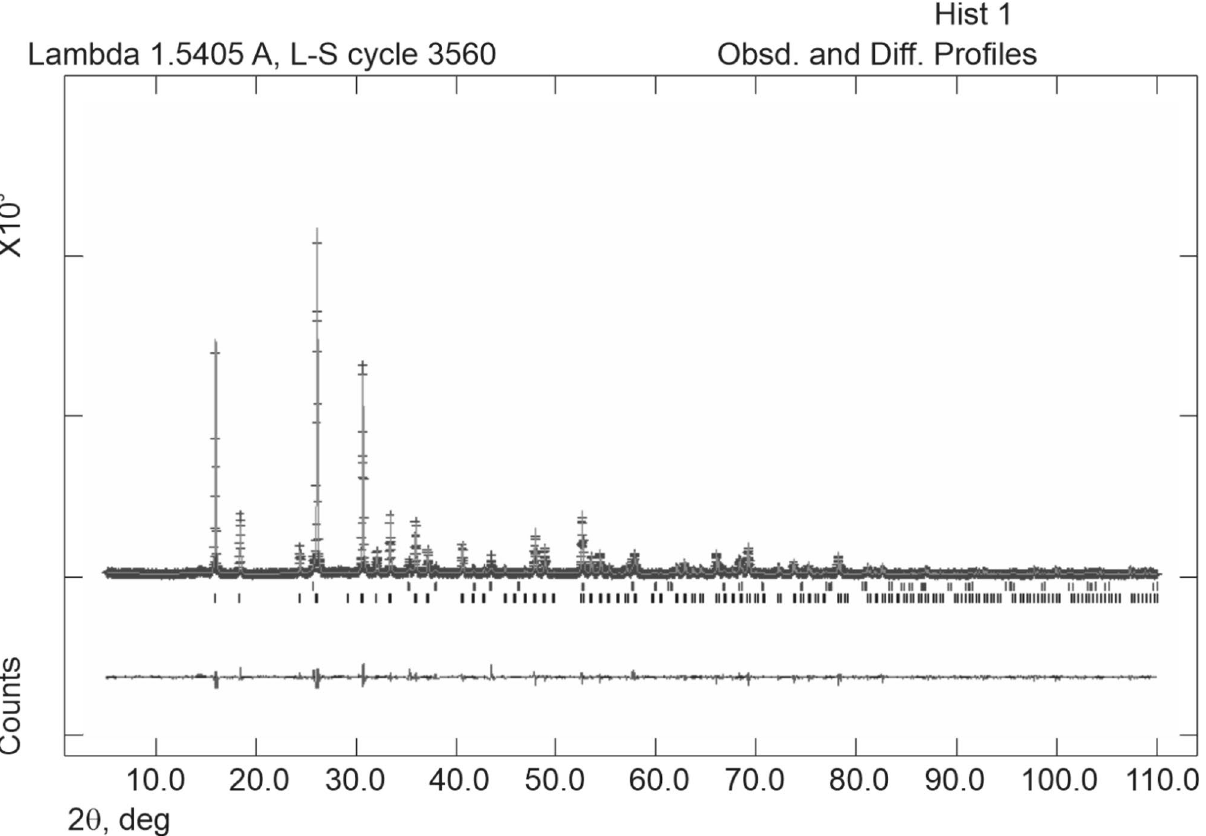
Figure 2. Rietveld refinement plot: Observed ( +) and calculated profiles and difference plot for analcime zeolite (10 h at 170 °C) and corundum NIST 676a with tick marks at the position of the Bragg peaks. From the bottom: analcime zeolite, corundum NIST